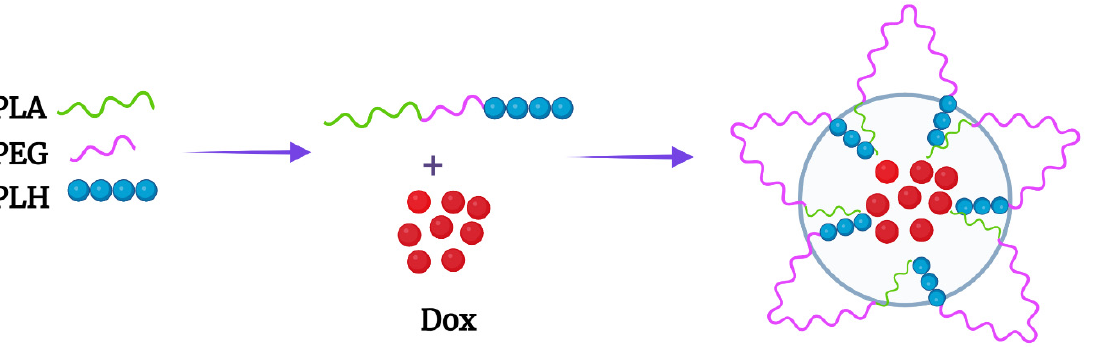
Figure 1. Flower-like micelle formed by the PLA-b-PEG-b-PLH triblock copolymer. Dox was incor- porated within the PLA and PLH hydrophobic core.